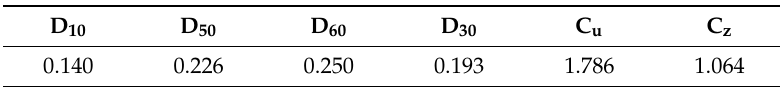
Table 6. Results from urease activity tests.